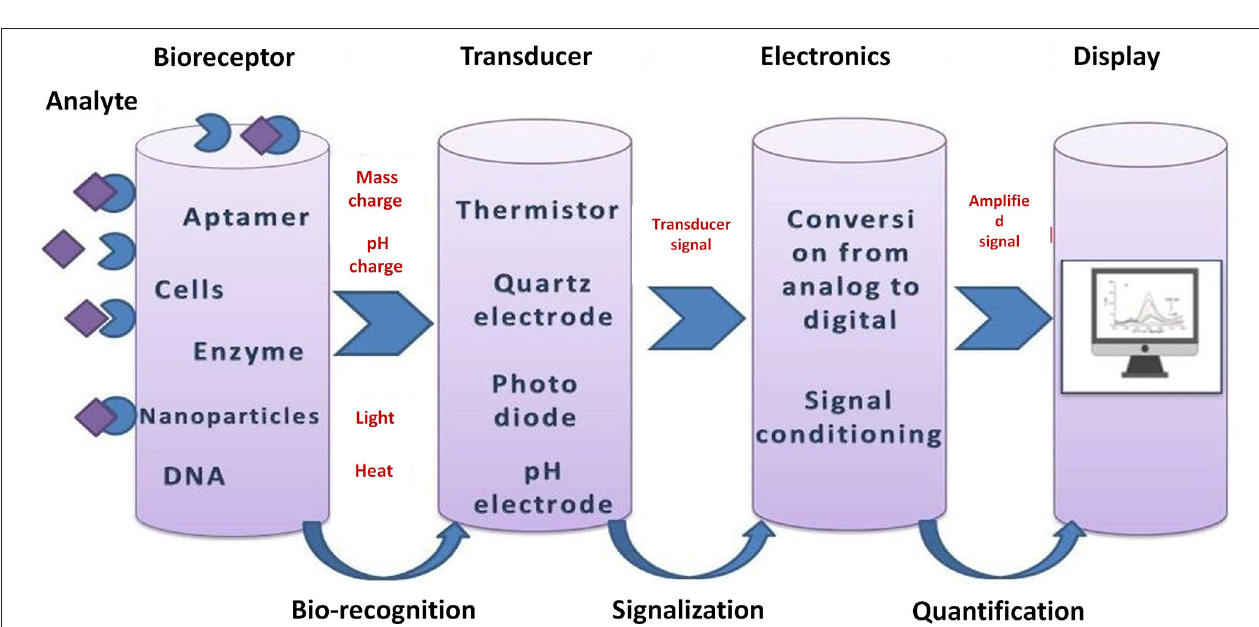
FIGURE 2 | Schematic representation of a (bio)sensor.